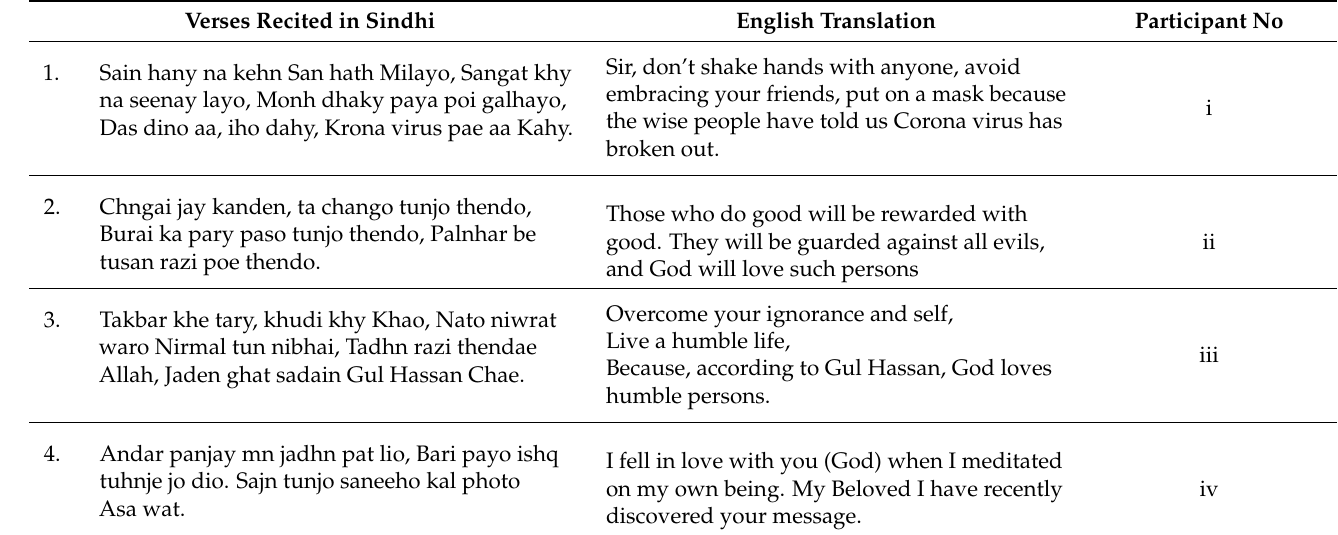
Table 2. Poetry recited by the participants in their